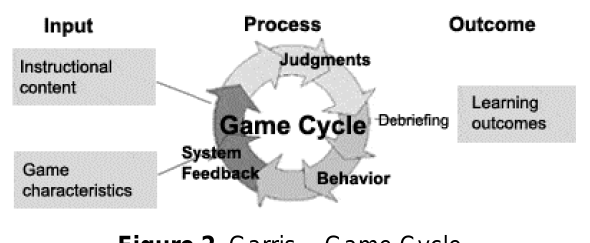
Figure 2. Garris – Game